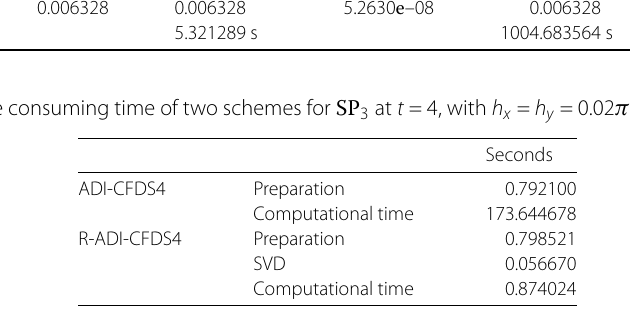
Table 16 Numerical results of SP 4 at t = 2, with h = 0.02 π , τ = 0.02 ( x , y ) Exact R-ADI-CFDS4 Error 1 ADI-CFDS4 Error 2 (0.2 π ,0.2 π )